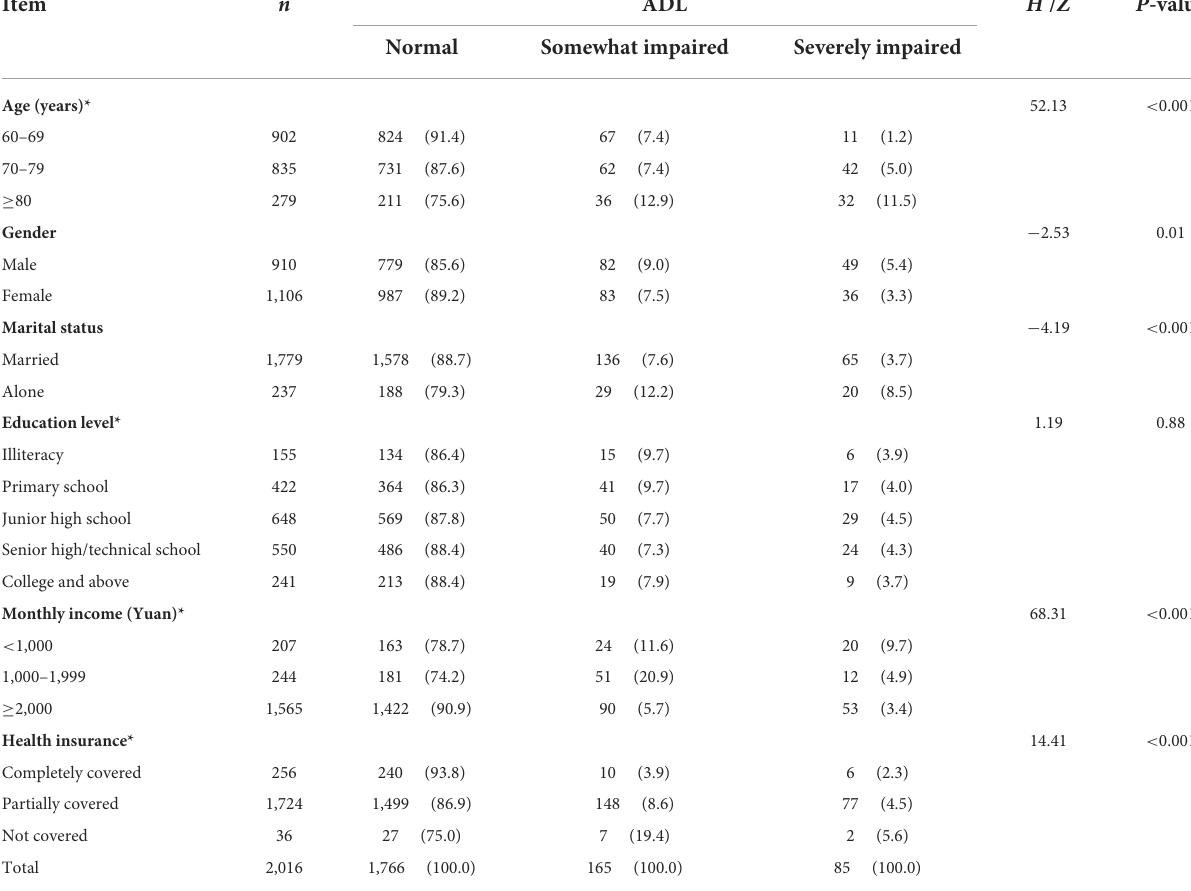
TABLE 2 Comparison of activities of daily living (ADL) by demographic characteristics in older people with type 2